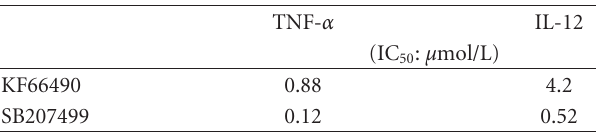
Table 3: IC 50 values of KF66490 and SB207499 on LPS- induced cytokine production from thioglycolate-elicited peritoneal macrophages.